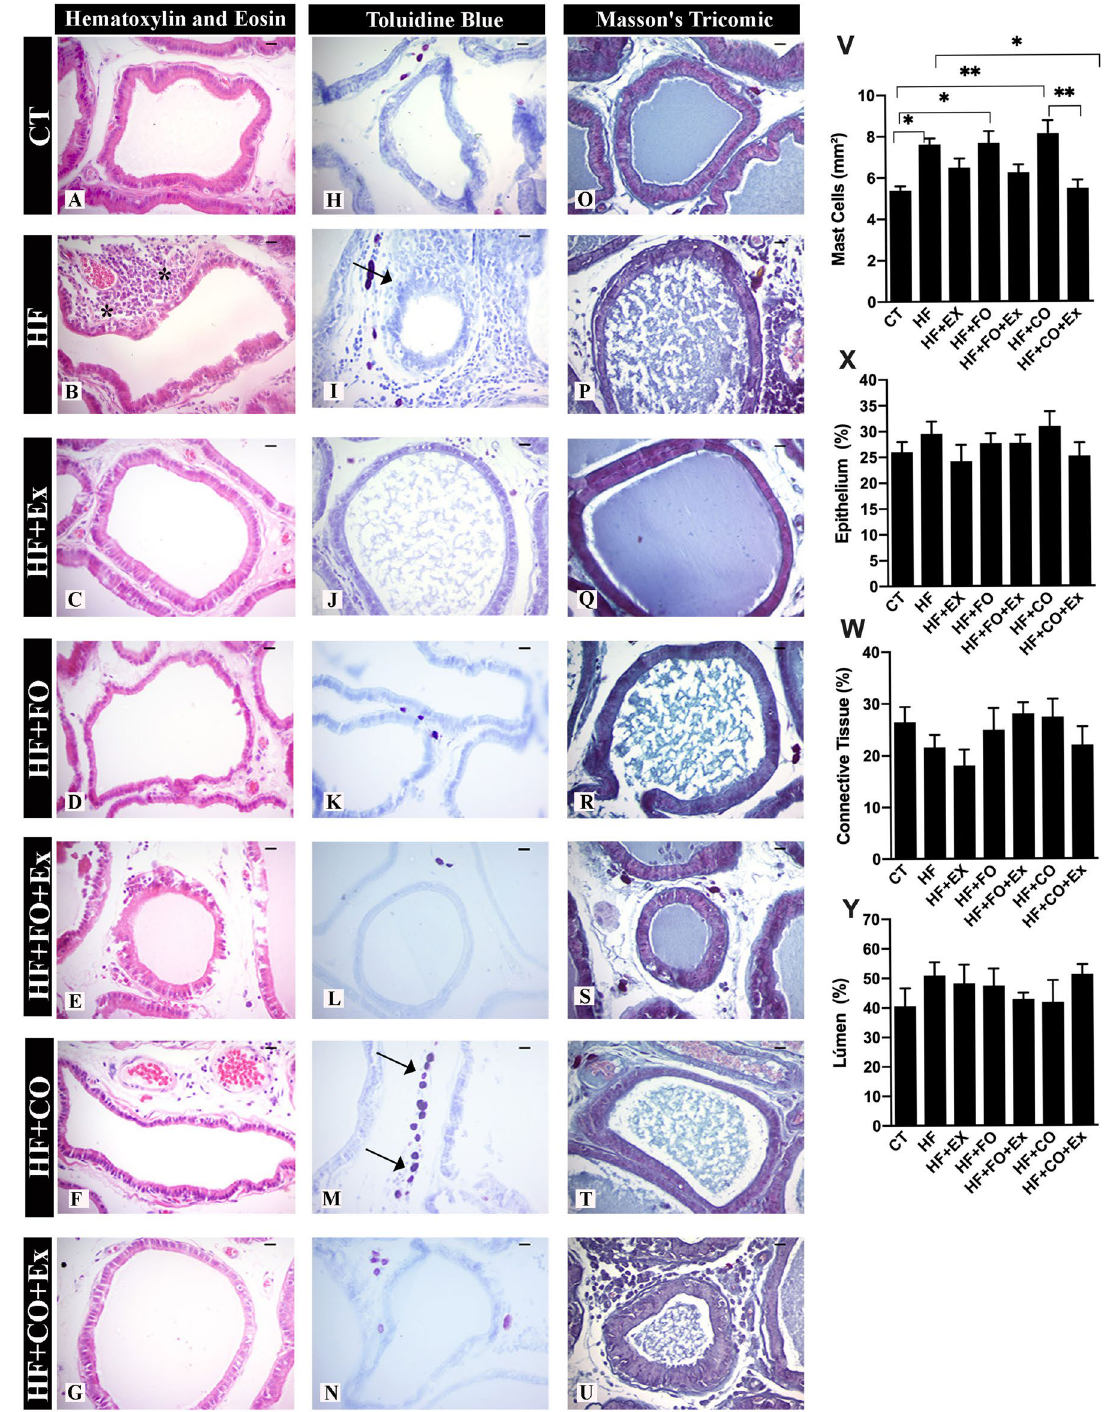
Figure 3. The data are presented as the mean ± SEM (n = 7). The significance of p < 0.05 is indicated by * indicating a difference between the groups. The asterisk * in H&E technique represents shows rounded acini with polymorphonuclear cells around prostate epithelium and the arrows in toluidine’s blue demonstrate the mast cells in connective tissue of prostate. CT control, HF high-fat diet, HF + Ex high fat and aerobic exercise, HF + FO high fat and fish oil, HF + FO + Ex high fat, fish oil and aerobic exercise, HF + CO high-fat diet and chia oil, HF + CO + Ex high fat, chia oil and exercise group. Graph V: referring to the number of mast cells per mm 2 ; Graph W: referring to the prostatic epithelium; Graph X: referring to prostatic connective tissue; Graph Y: referring to the amount of prostatic lumen. Bar = 20 µm; Resolution = ×40. The Two-Way ANOVA test was used to compare the means, with the Tukey